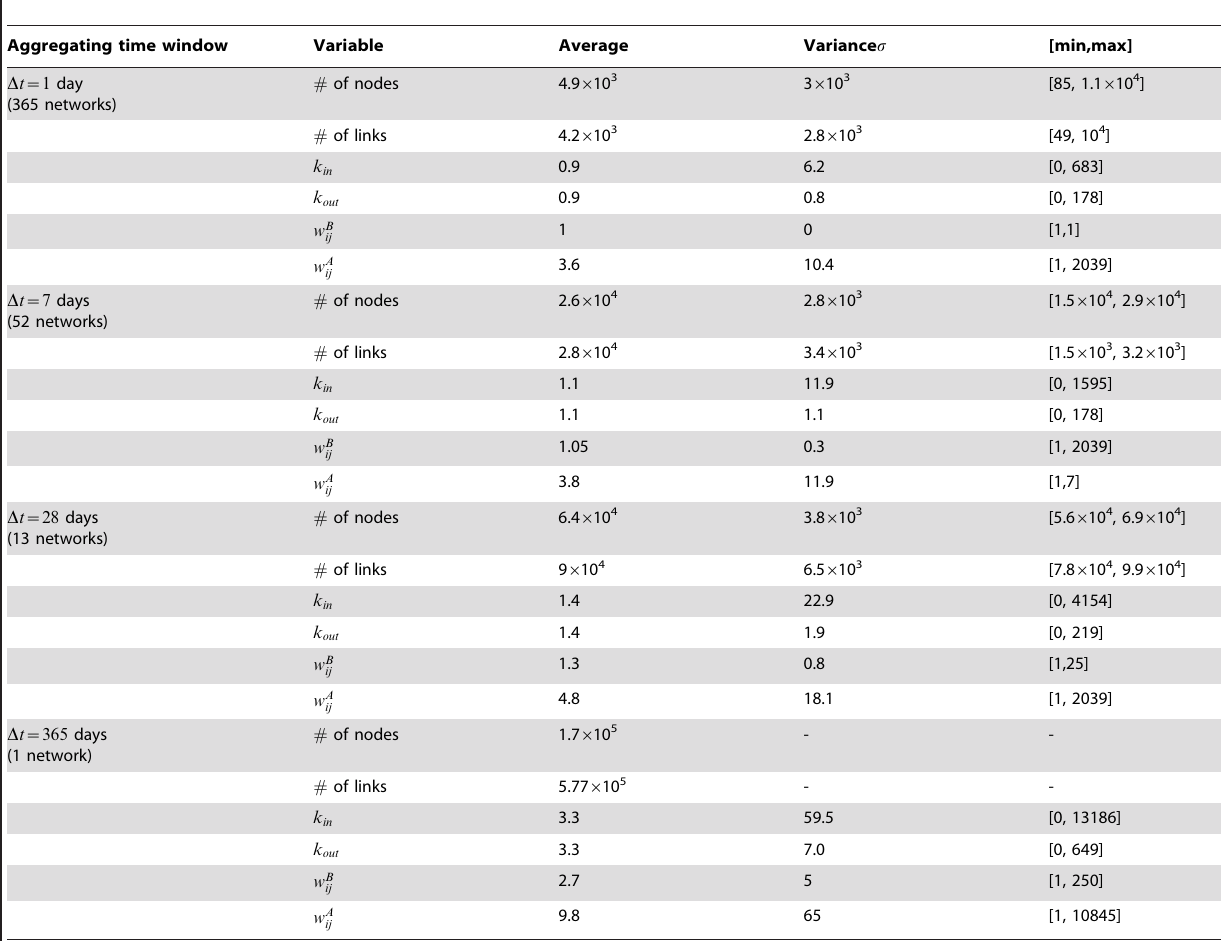
Table 2. Summary of the main features of the mobility networks obtained by aggregating the data over a time window D t